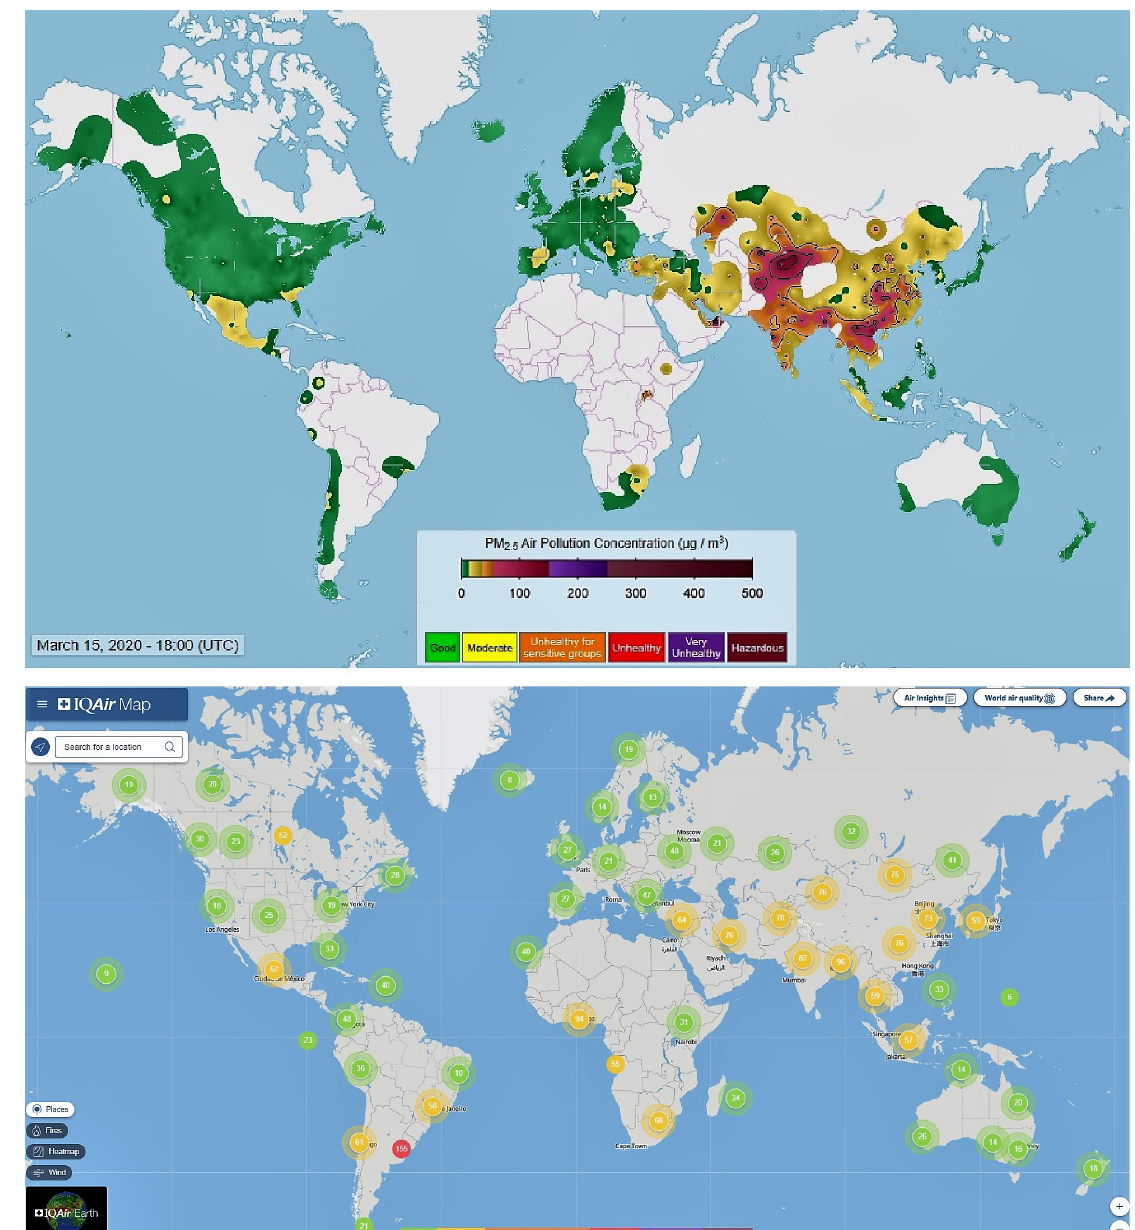
Figure 10. Top: near real-time information on particulate matter air pollution less than 2.5 microns in diameter (PM2.5). The image refers to 15 March 2020, at 18:00 UTC. Bottom: a typical World Air Quality Index (AQI) map from